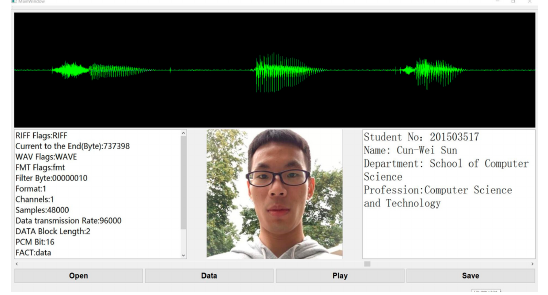
Figure 16. Software interface based on voiceprint identification.